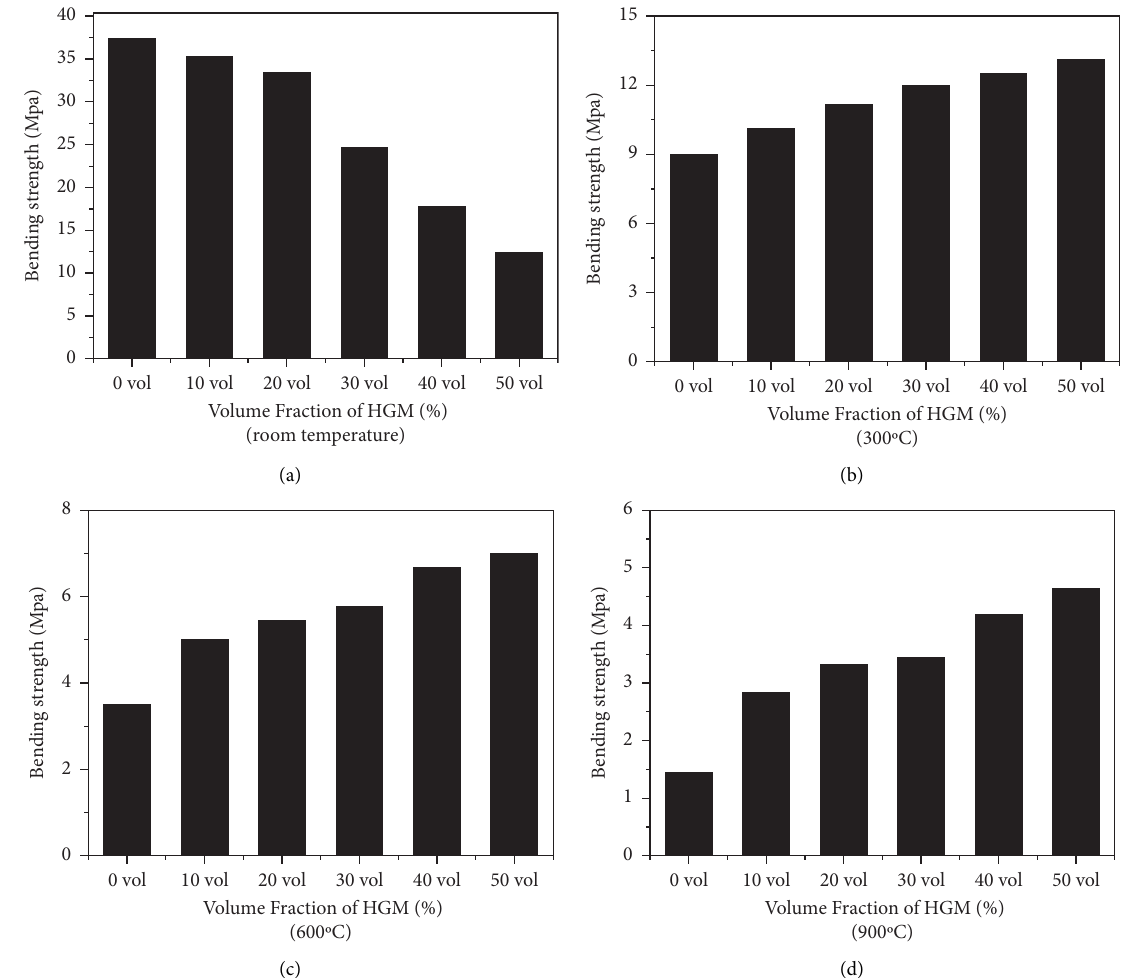
Figure 7: Flexural strength of HGM/microsphere syntactic foam at different